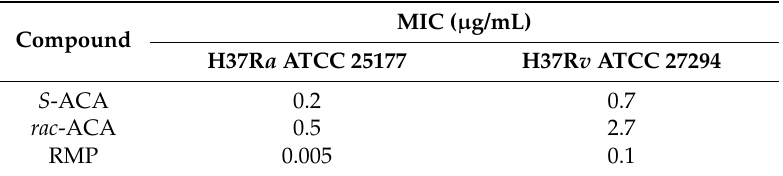
Table 1. Minimum inhibitory concentrations (MICs) of 1 (cid:48) - S -acetoxychavicol acetate (S -ACA) purified from A. galanga , racemic ACA ( rac -ACA) and rifampicin (RMP) against M. tuberculosis H37R a and H37R v strains.